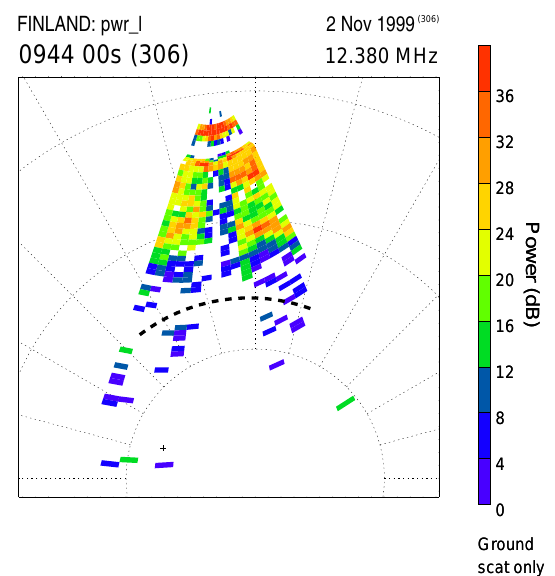
Fig. 11. The dayside portions of convection maps (centered at 12:00 MLT). The fitted convection velocity vectors are colour- coded. Contours (solid and dashed) of the electrostatic potential Fig. 11 are shown with the value of the cross-polar cap potential difference given (top-left). The IMF B z vs. B y clock-dial plot is shown (top- right).